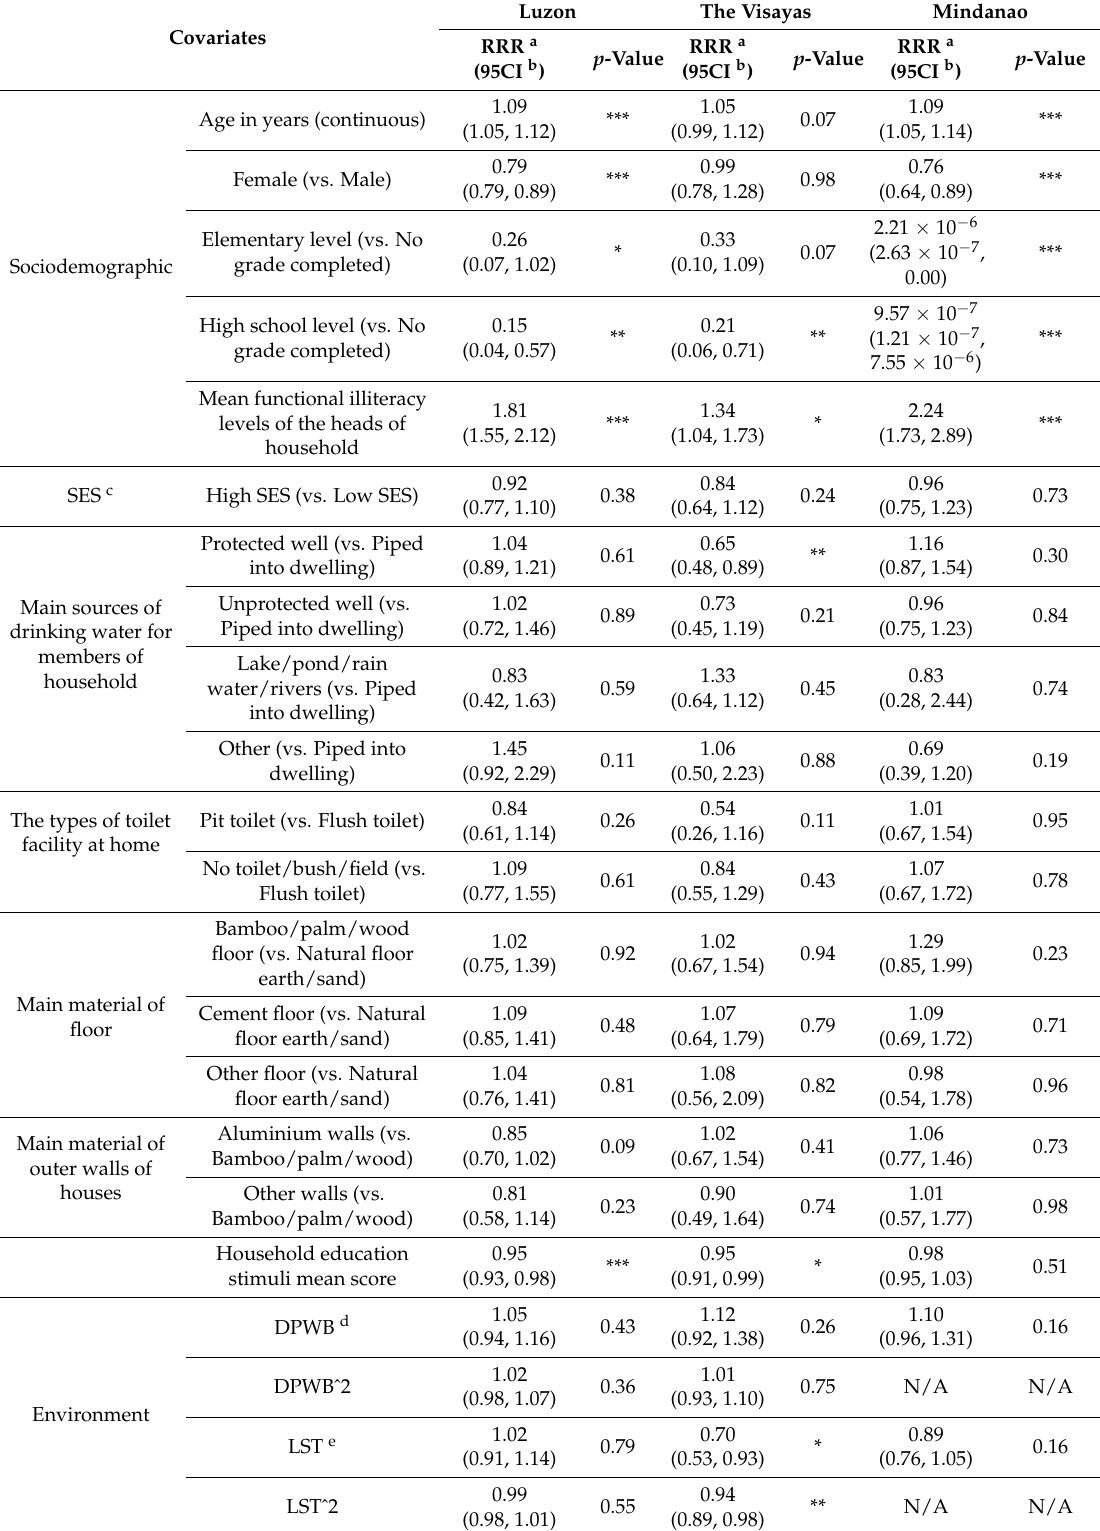
Table 4. Association of selected covariates with moderate functional literacy in school-aged children in the Philippines (Model